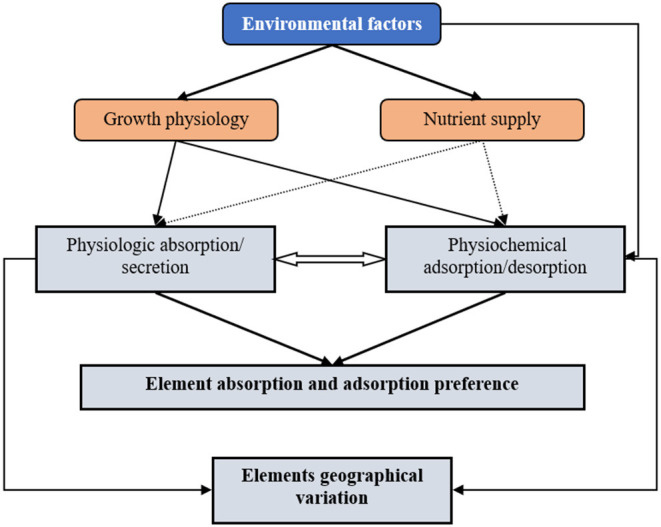
The schematic diagram showing environmental factors control the mineral patterns of N. commune. Environmental factors (especially precipitation and temperature) shape the element absorption and adsorption preference and the elements geographical variation of N. commune. Environmental factors (especially precipitation and temperature) can indirectly influence physiologic absorption/secretion and physiochemical adsorption/desorption by regulating growth physiology of N. commune, and can also directly influence the physiochemical adsorption/desorption of N. commune.